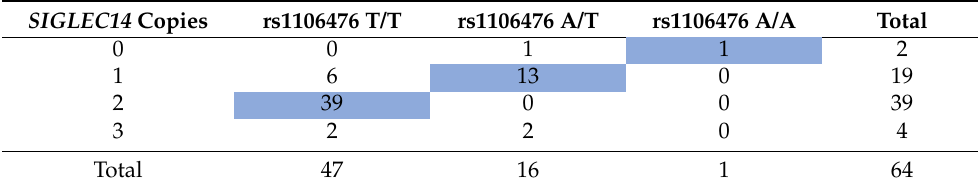
Table 3. Evaluation of rs1106476 as a proxy for SIGLEC14 deletion.